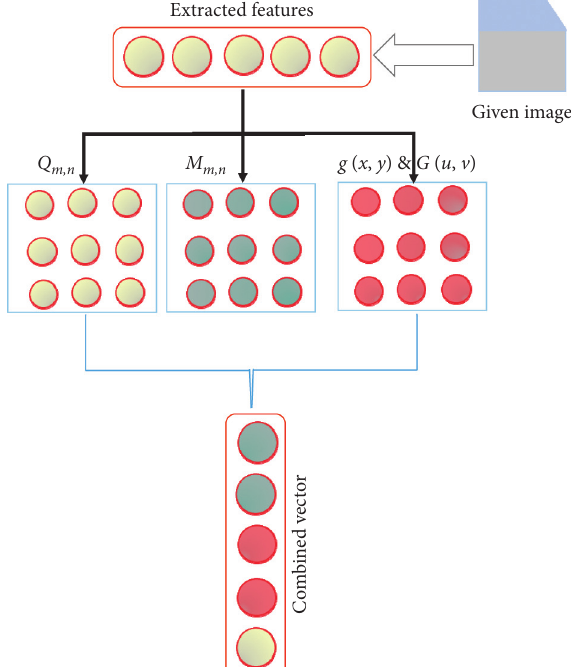
Figure 7: Texture features filtered from the original image and combined with other extracted